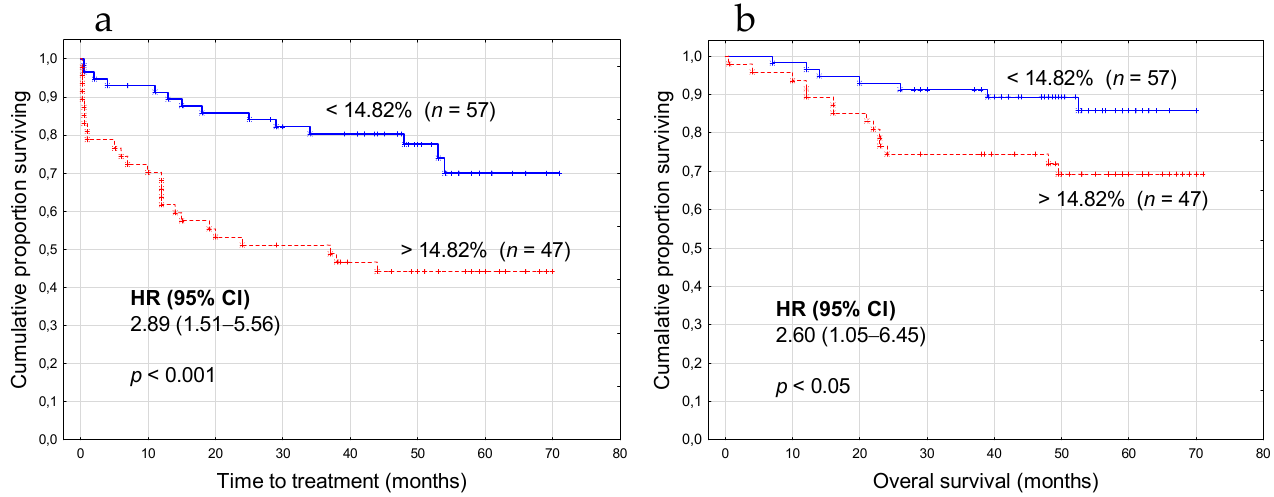
Figure 6. Kaplan–Meier curves based on a cut-off value of 14.82% for a TEM percentage, comparing TTT (time to treatment) among patients with CLL ( a ). Kaplan–Meier comparing OS (overall survival) among CLL patients ( b ). HR, hazard ratio; CI, confidence